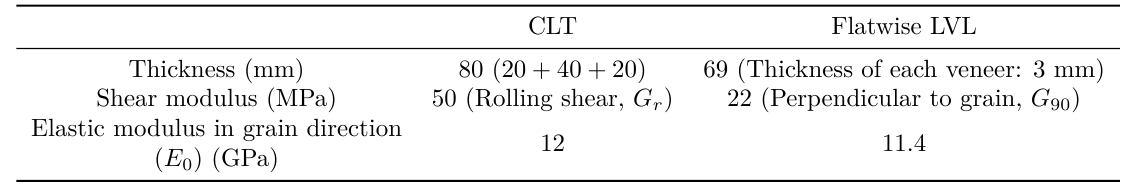
Table 1. Mechanical properties of the engineered wood products